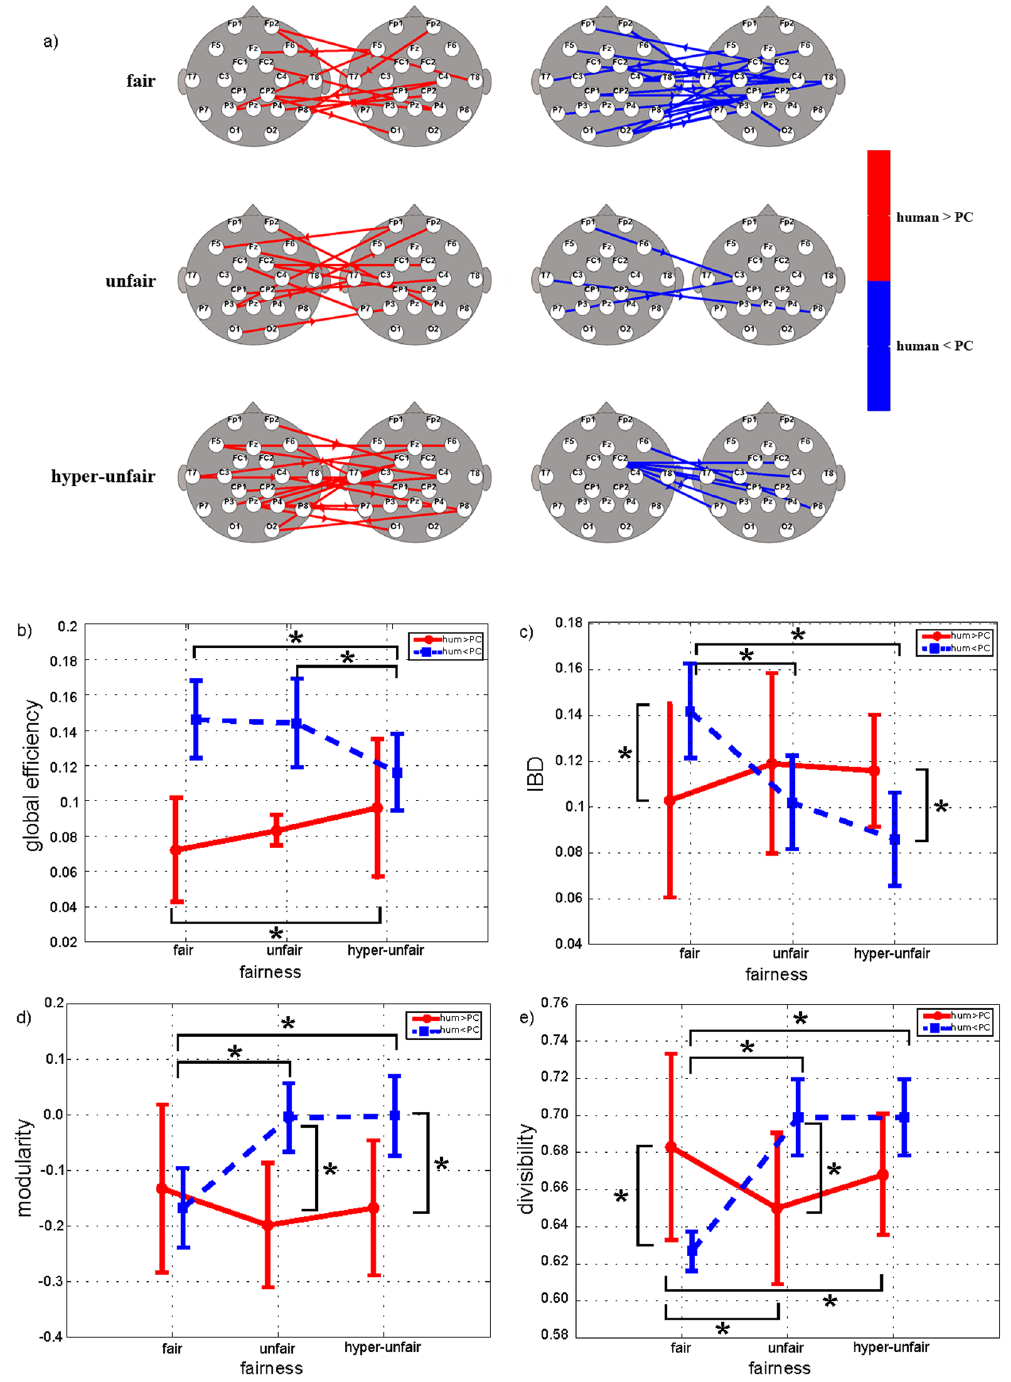
Figure 4. ( a ) Statistical interbrain connectivity patterns in theta band. Statistical interbrain connectivity patterns comparing human vs PC conditions in the theta band (group analysis, paired t-test; p < 0.05 FDR-corrected). The patterns were reconstructed for the three fairness levels separately. Red arrows indicate human > PC, and blue arrows indicate human < PC. b,c,d,e) Results of two-way ANOVA on global efficiency (p = 0.00024, F(2,28) = 11.39) (panel b), interbrain density (p = 0.0003, F(2,28) = 11.13) (IBD - panel c), modularity (p = 0.016, F(2,28) = 4.84) (panel d), and divisibility (p = 0.0007, F(2,28) = 9.62) (panel e) computed for connectivity networks in theta band. * Indicates statistical differences as confirmed by Neumann-Keuls post hoc test (p <